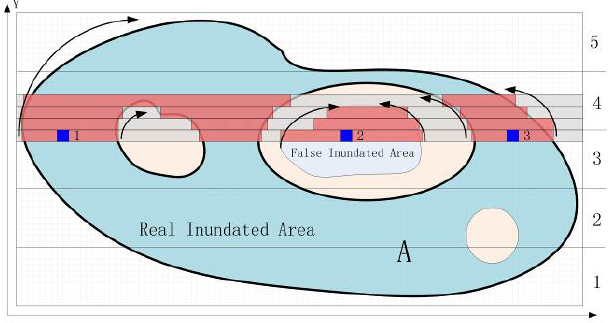
Figure 7. Run-length compressed encoding for the digital elevation model (DEM).